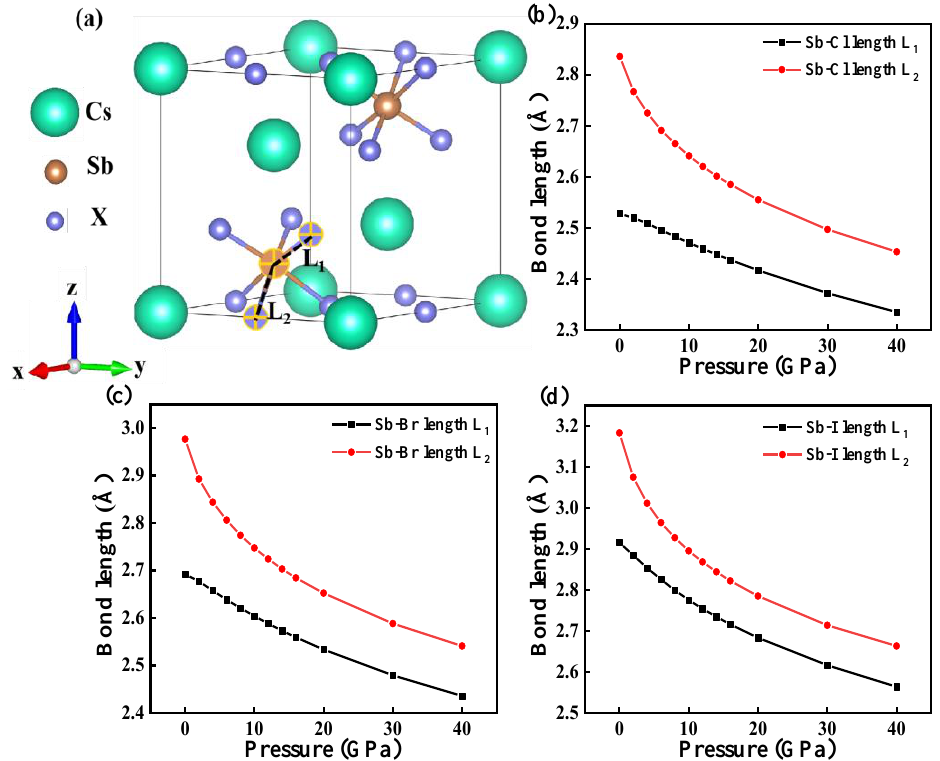
Figure 4. ( a ) Two types of Sb-I bonds L 1 and L 2 . Calculated bond length as a function of pressure for Cs 3 Sb 2 Cl 9 ( b ); Cs 3 Sb 2 Br 9 ( c ); and Cs 3 Sb 2 I 9 ( d ); as a function of pressure.